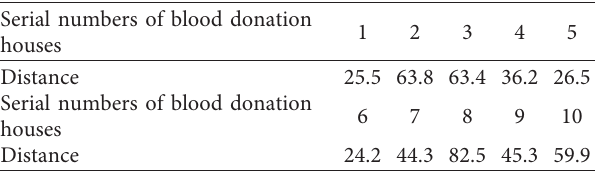
Table 5: Distance A jk from the blood donation houses to the blood centres (unit: km).